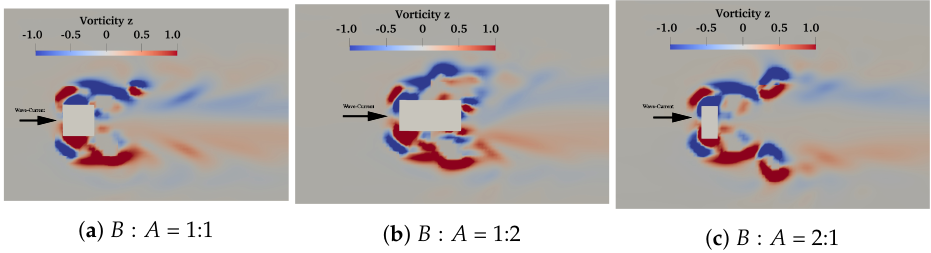
Figure 13. Vorticity contours for KC number = 5.75 for and wave − current parameter ( U cw = 0.4) for varying aspect ratios of the rectangular pile.